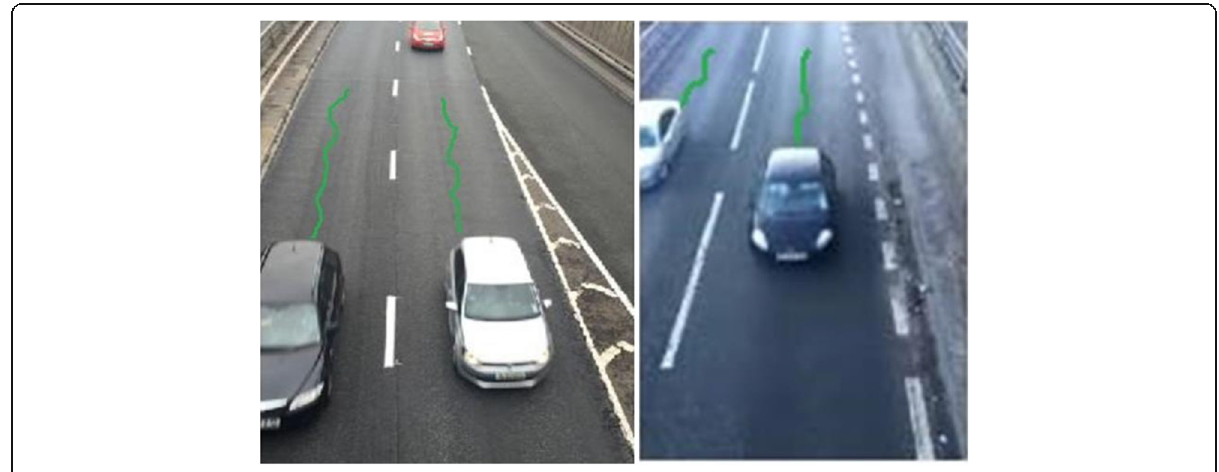
Fig. 9 Vehicle chaotic trajectories from two different videos